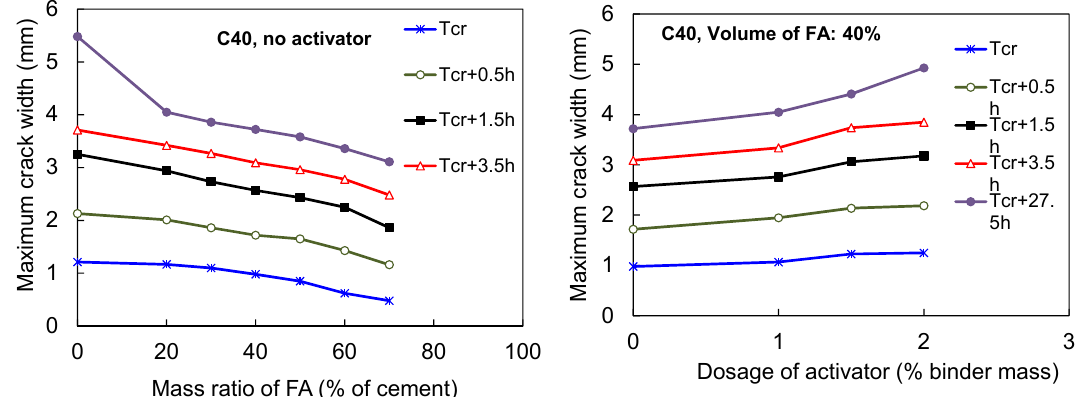
Figure 12. Effect of the mass of FA and dosage of AC (Na 2 SO 4 ) on crack width.